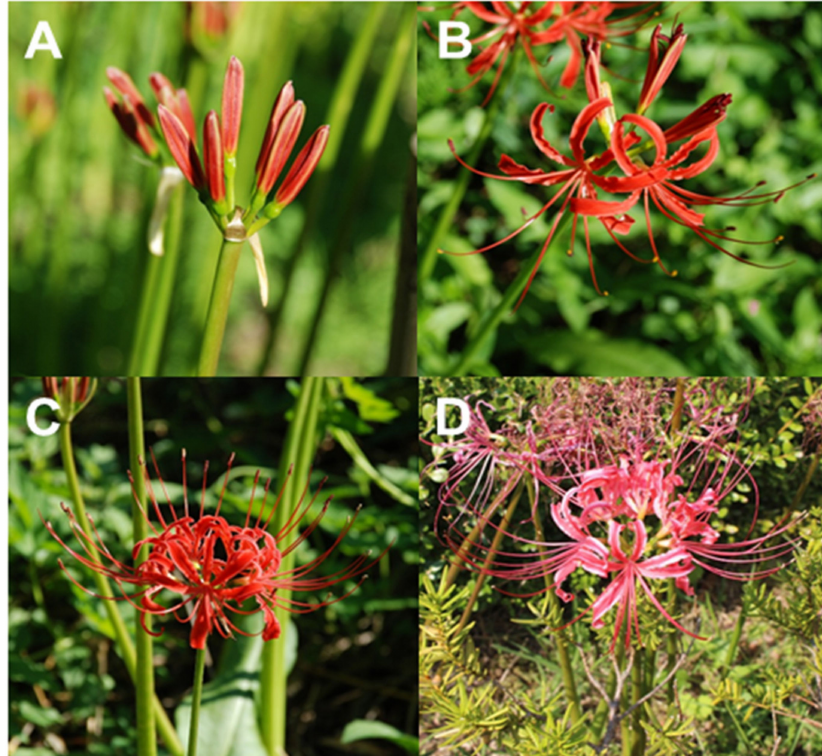
Figure 1. Four stages of Lycoris radiata flower development. ( A ) Floral bud (stage 1); ( B ) partially opened flower (stage 2); ( C ) fully opened flower (stage 3); and ( D ) senescent flower (stage